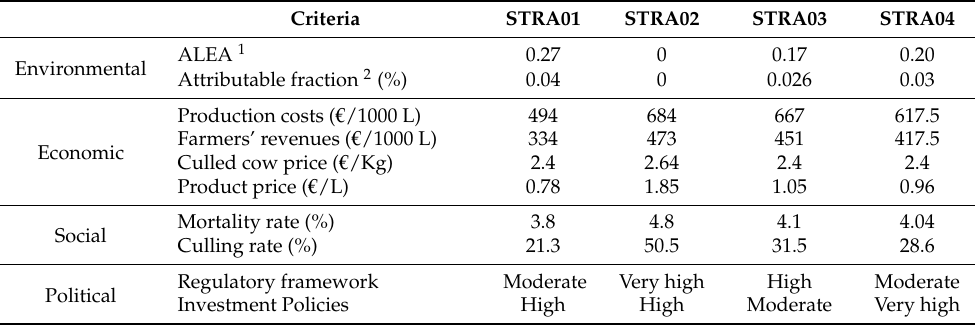
Table 3. Criteria and scaled measures used in the PROMETHEE models under strategies (STRA) for reducing antimicrobial use in French dairy